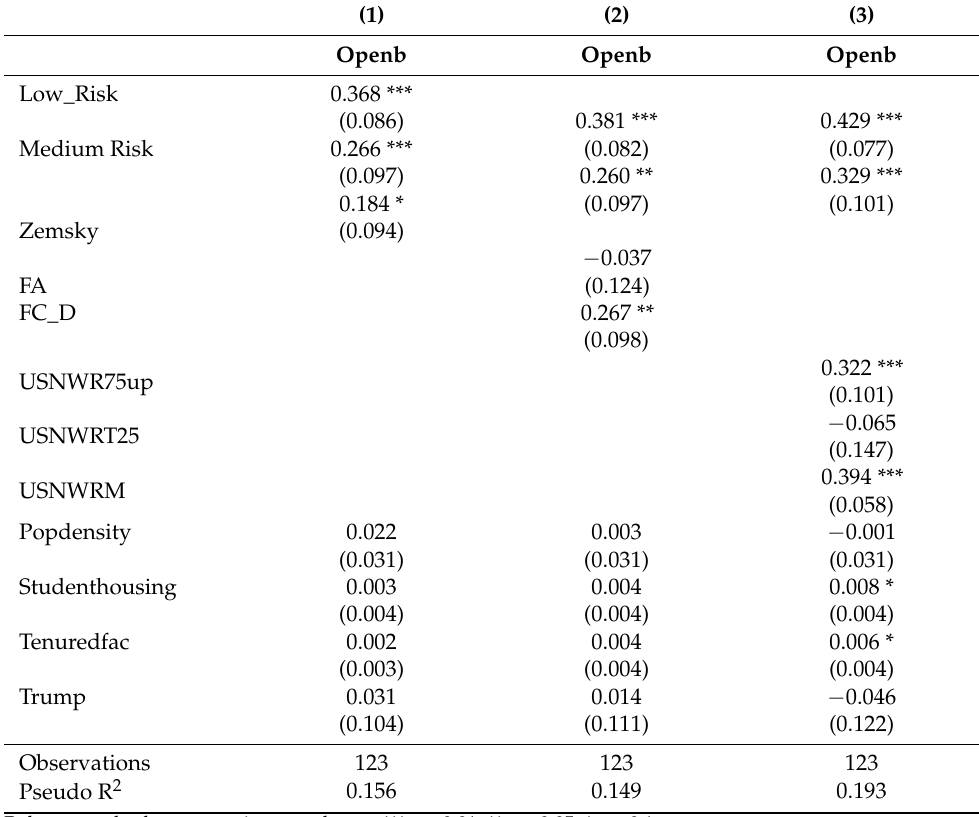
Table 4. Probit Models Using Alternative Measures of Financial Health (Marginal